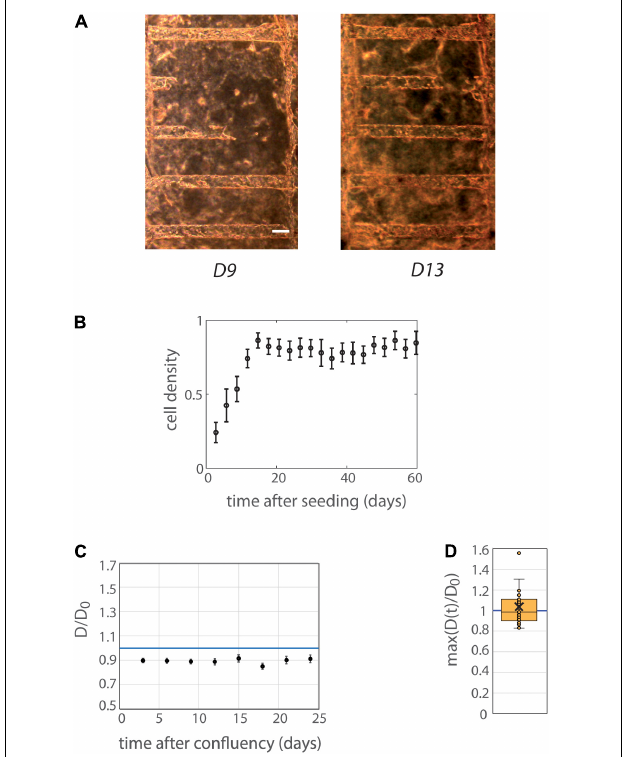
FIGURE 2 | Behavior of MDCK cells in tubes. (A) MDCK-Lifeact-GFP cells were seeded within tubes molded in collagen I at 6 mg/ml, and observed under an optical microscope over time. The temporal evolution at days 9 and 13 after seeding is represented (before and at confluency) is represented. Scale bar: 100 µ m. (B) Mean cell density over time ( n = 12 MDCK chips). The temporal scale refers to time after cell seeding for colonization curves. Tubes with or without laminin coating were pooled, because of similar behaviors in these two conditions (see Supplementary Figure 8 for separated behavior). The mean curve remains below cell density 1 (corresponding to full colonization) reflecting the fact that some tubes were never fully colonized with cells. Error bars: S.E.M. (C) Kinetic evolution of mean tubes diameter normalized by diameters at seeding as function of the time after tube confluency. The temporal scale refers to time after confluency for curves of tube deformation. A blue horizontal line at D/D 0 = 1, corresponding to no change in diameter, is indicated. Chips with or without laminin coating were pooled. Each time point corresponds to 19–30 tubes. Error bars: S.E.M. (D) Maximum (over time) of the mean normalized diameter. Tubes with or without laminin coating were pooled. Points correspond to individual tube values. Central bar, median; cross, mean; box, values between Q1 and Q3 quartiles; error bars, extreme values [between Q1 - 1.5*(Q3 - Q1)